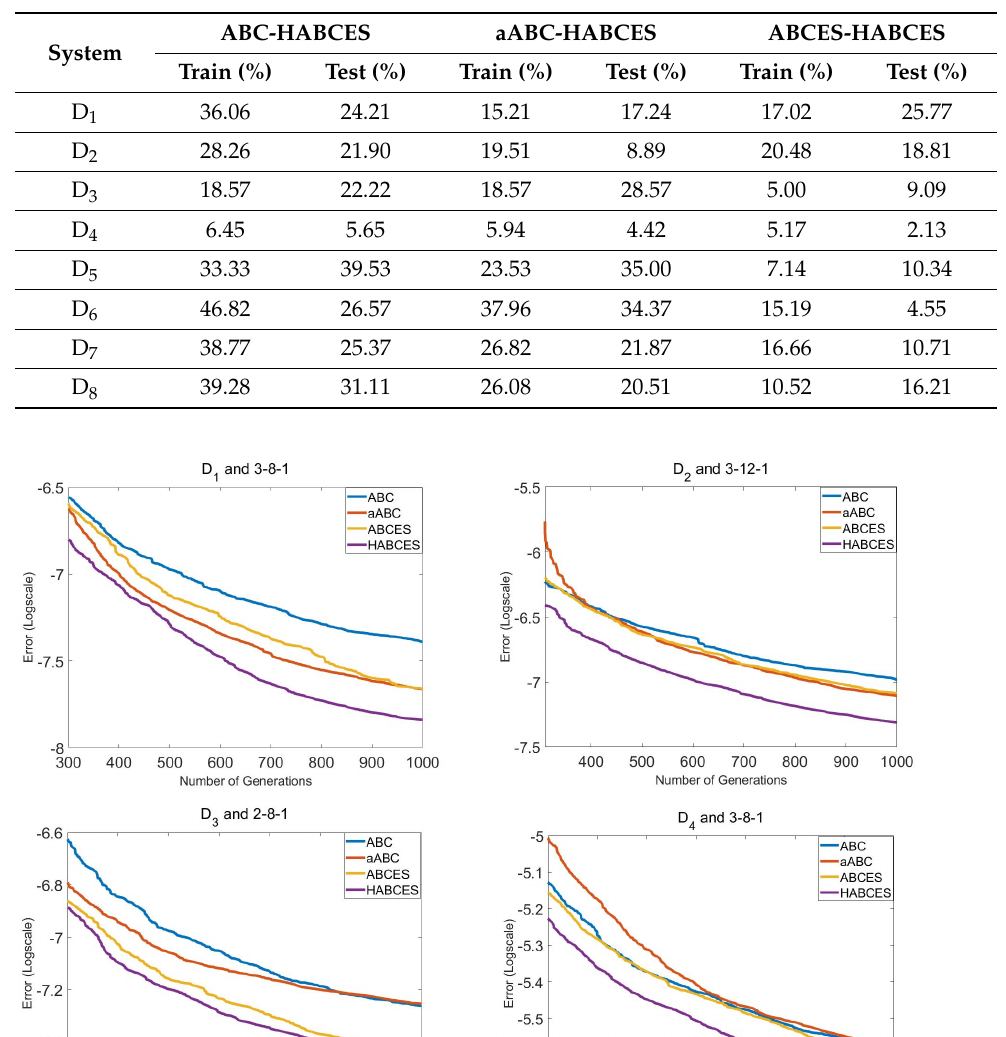
Figure 8. Comparison of the convergences of the ABC, aABC, ABCES and HABCES algorithms for nonlinear dynamic system identification.